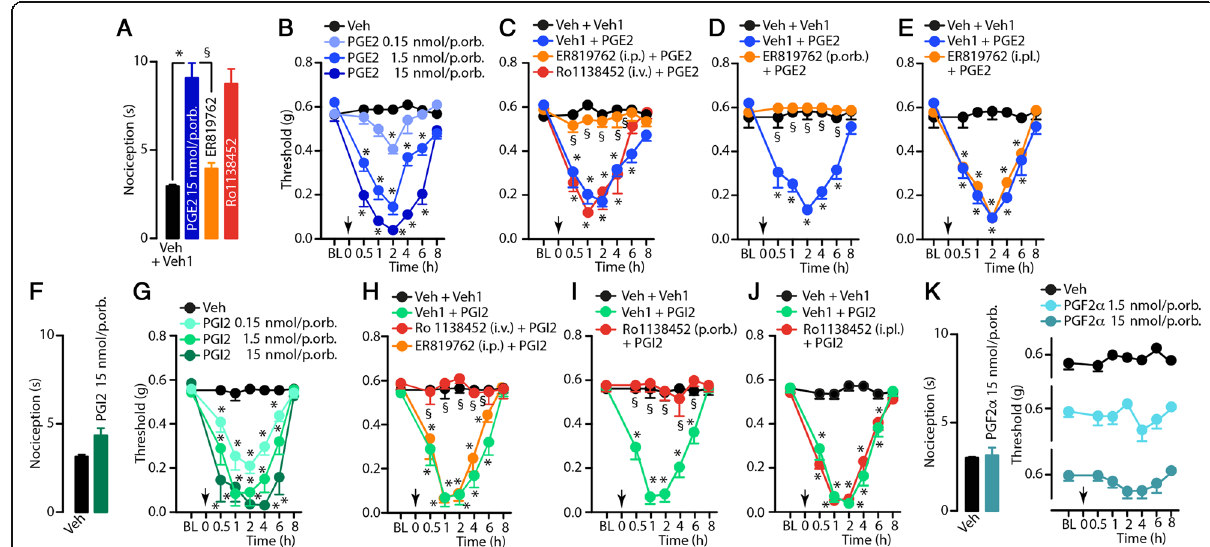
Fig. 4 a Effect of pretreatment with intraperitoneal (i.p., 60 μ mol/kg) ER819762 or intravenous (i.v., 30 μ mol/kg) Ro1138452 on the